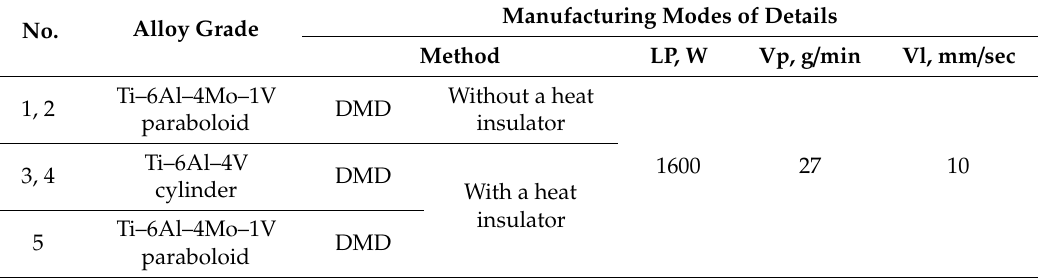
Figure 1. FL-Clad-R-4 complex of laser melting of metals (for DMD method): ( a ) General appearance; ( b ) Inner space of the process chamber. Table 1. Compositions of metal powders, laser power (LP), powder feed speed (Vp), laser head displacement speed (Vl).